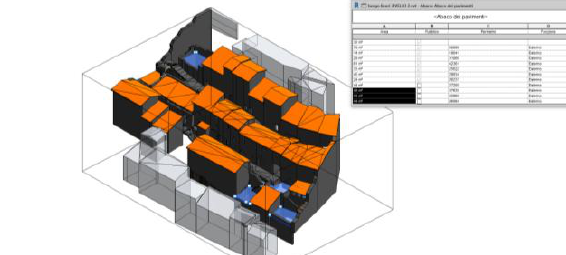
Figure 10. External private and public spaces as the example of the Pattern